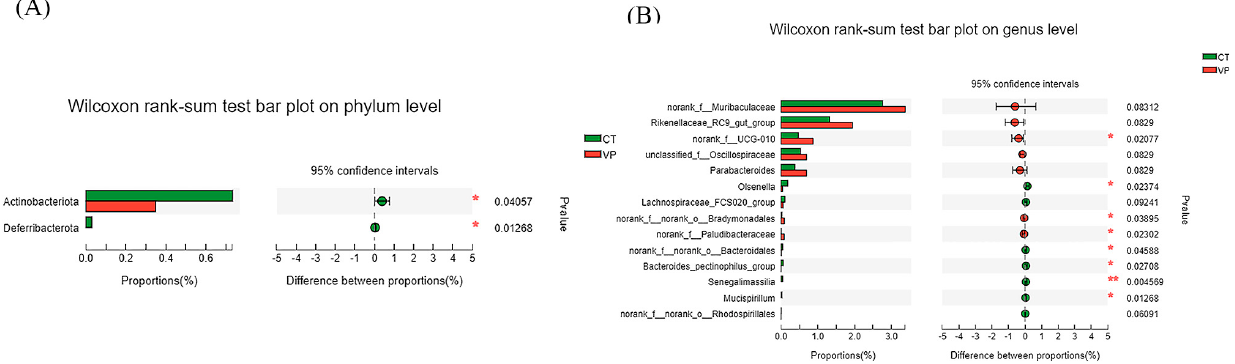
Figure 4. ( A ) Significance test of the difference between treatments at phylum. ( B ) Significance test of the difference between treatments at genus levels, the Y − axis represents the species names at a certain taxonomic level, the X − axis represents the average relative abundance in different groups of species, and the columns with different colors represent different groups; the far right is the p − value, * p < 0.05, ** p < 0.01.